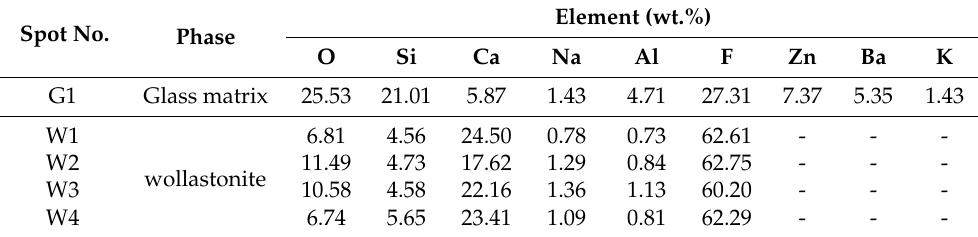
Table 3. Semiquantitative energy spectrum analysis of the selected phases shown in Figure 6. Spot No.